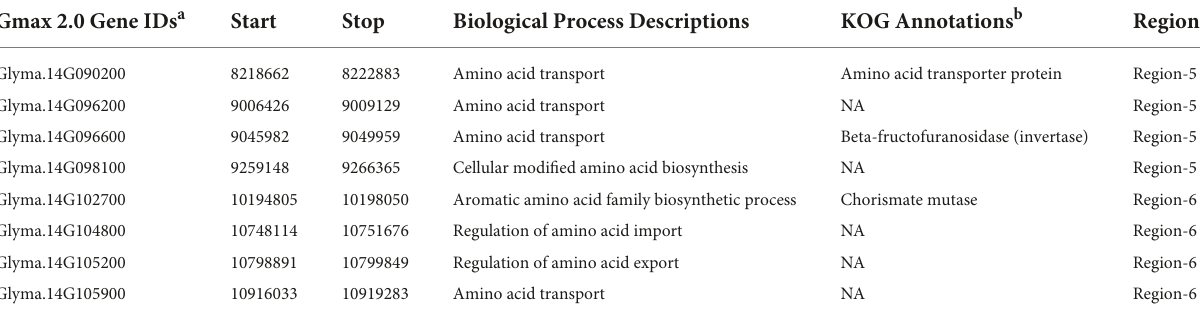
TABLE 6 Candidate protein-related genes within regions 5 and